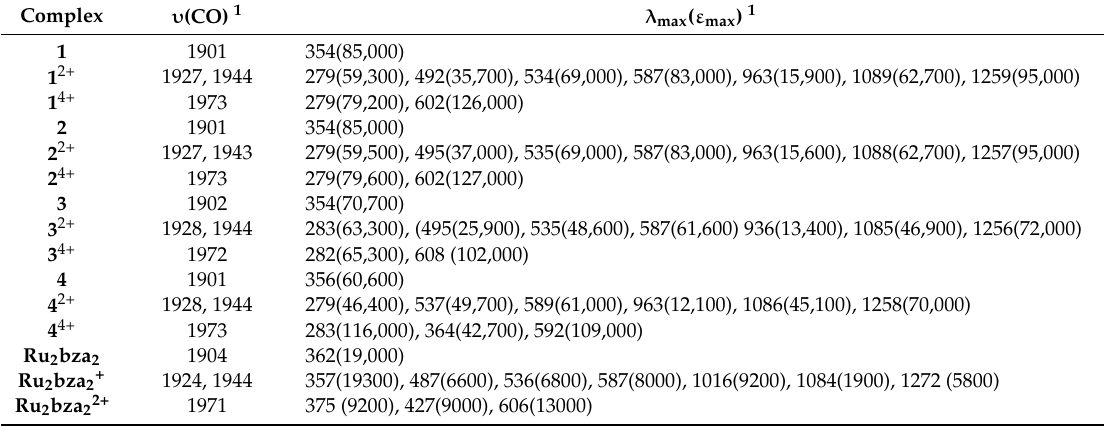
Figure 7. Spectroscopic changes of the Ru(CO) bands ( left ) and in the near infrared ( right ) during the oxidation of the neutral macrocycle 1 to its dication 1 2+ ( top ) and from dication 1 2+ to the tetracation 1 4+ ( bottom ) in 1,2 ‐ C 2 H 4 Cl 2 /0.1 M NBu 4+ PF 6 − , at r.t. Table 2. Energies of the υ (CO) stretches and UV/Vis/NIR data for macrocycles 1 – 4 and the analogous diruthenium complex Ru 2 bza 2 in their various oxidation states 1,2